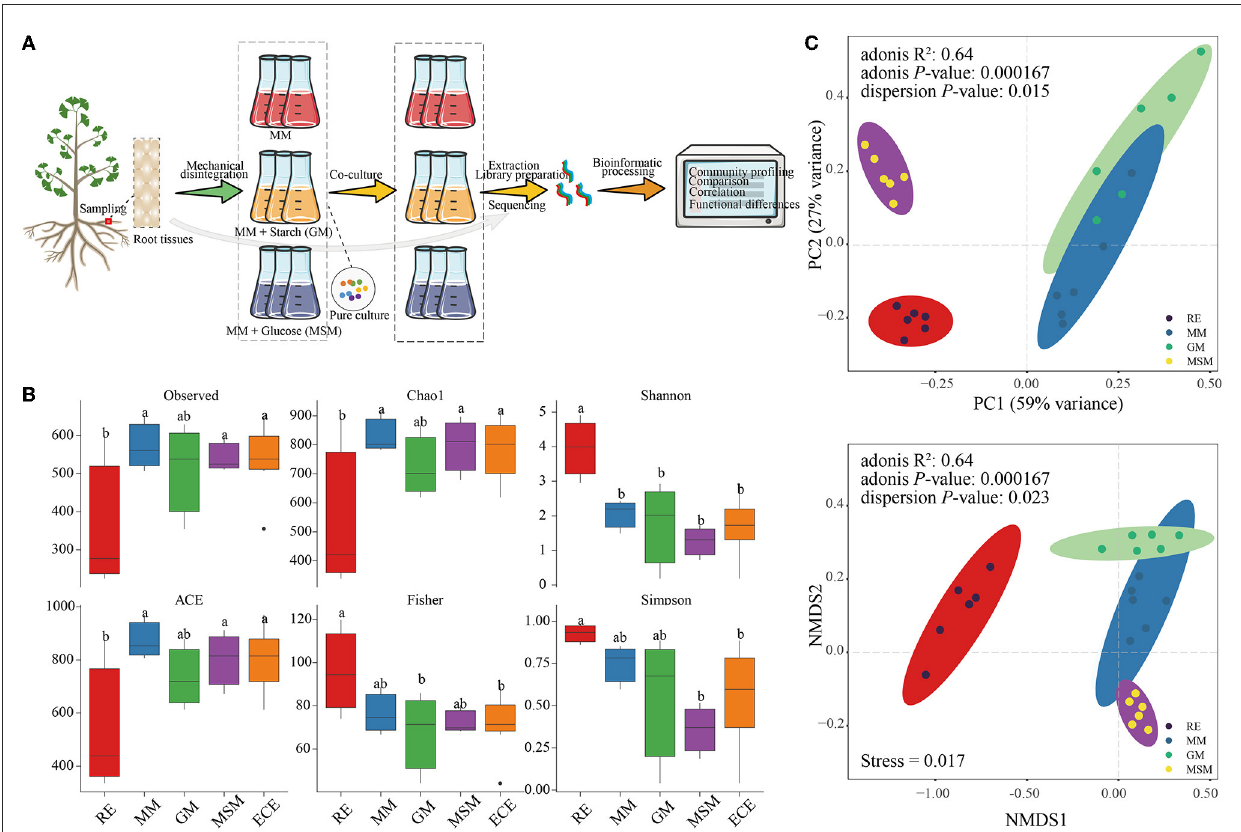
FIGURE1 Schematic procedure of cultivating the endophytic bacteria of Ginkgo roots and the diversity of their bacterial communities. (A) A workflow enriching the endophytic bacteria of the Ginkgo root tissues. (B) Alpha diversity indices of bacterial communities in the in situ root tissues and the enrichment culture, including the Observed species, Chao1, Shannon, ACE, Fisher, and Simpson index. ECE represents the whole enrichment culture samples. (C) PCA and NMDS ordinations of the Bray–Curtis dissimilarity matrices with PERMANOVA, showing a significant variance of the bacterial community composition between the in situ root samples and enrichment collections. Table 1 presents a list of abbreviations of the groups used in the figure.